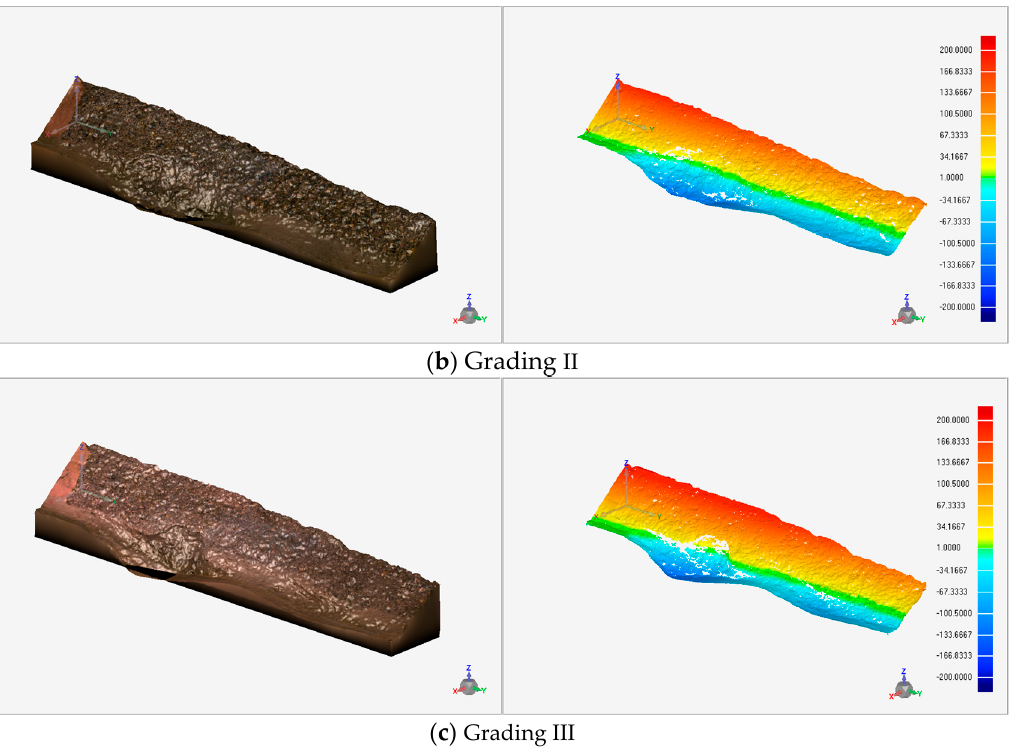
Figure 6. Comparison diagram of erosion of accumulation bodies with different gradations.